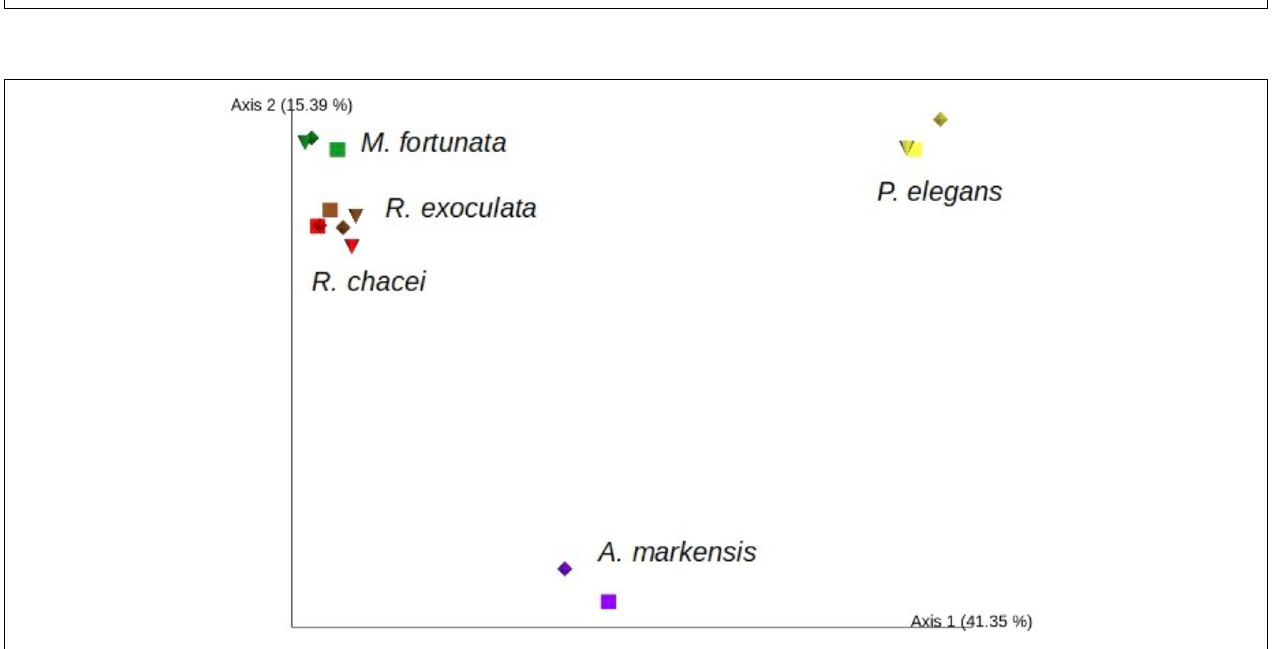
FIGURE 5 | Principal coordinates analysis, 2D plot of the distribution of samples from Alvinocaris markensis (purple), Rimicaris chacei (red), Mirocaris fortunata (green), Palaemon elegans (yellow), and Rimicaris exoculata (brown) according to the composition of associated bacterial communities estimated by 16S rRNA metabarcoding. Symbols correspond to the different appendages, namely A1lat (diamonds), A1med (square) and A2 (triangle). Axes 1 and 2 explained 41.35 and 15.39% of the observed variance, respectively.